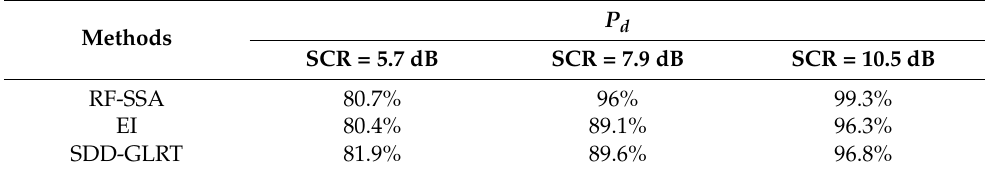
Table 8. Comparisons of the detection